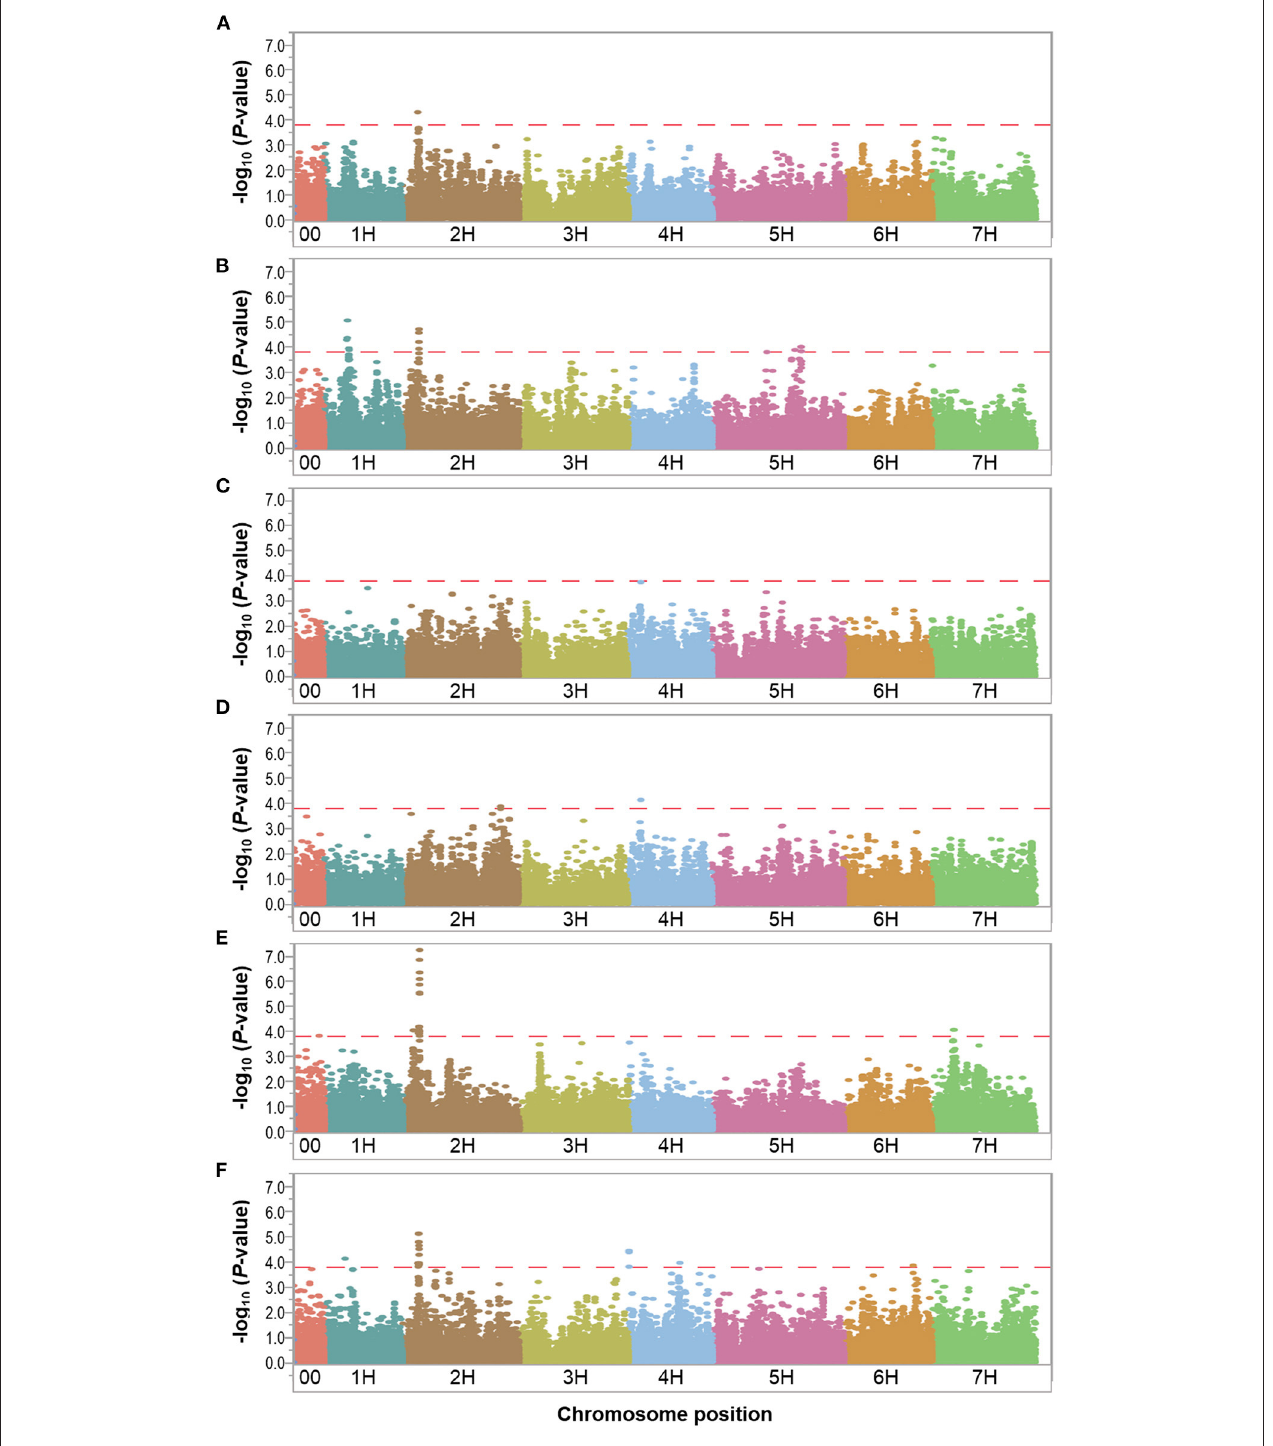
FIGURE 5 | Manhattan plots resulting from the SNP-based GWAS identified in the relative dataset. Manhattan plots for Biomass (BIO), Spikes per plant (SP), Grains per plant (GP), Kernel weight per plant (GWP), Plant height (PH), and Waterlogging score (WLS) are shown in (A–F) , respectively, and the x-axis shows SNP loci along the seven barley chromosomes. The horizontal red line shows the genome-wide significance threshold P -value of 1.6 × 10 − 4 or –log 10 ( P -value) value of 3.8. GWAS was performed using the MLM (Q + K) model in JMP Genomics for the field traits.